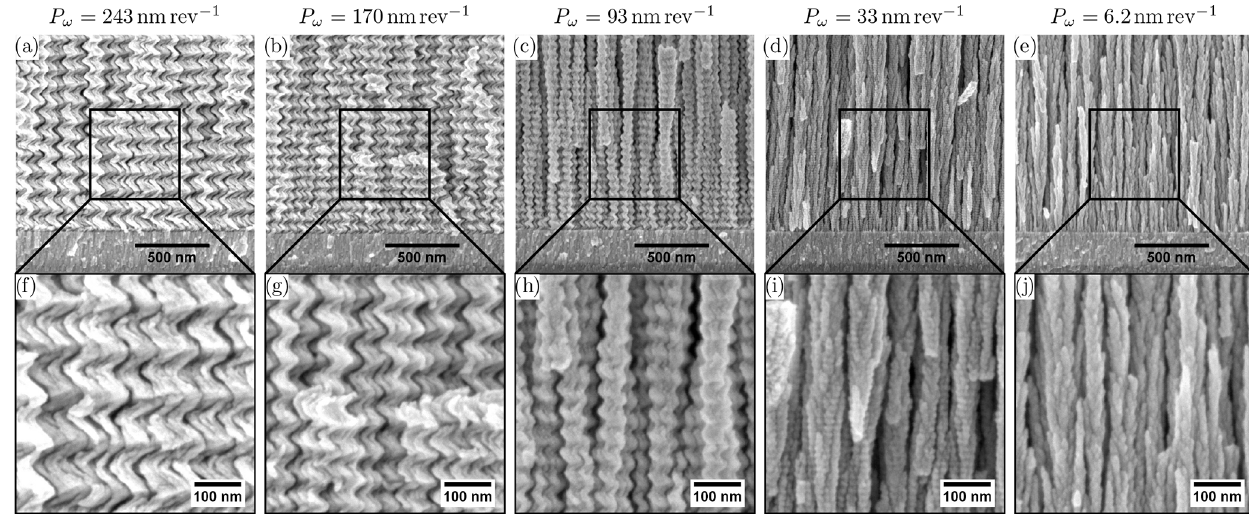
Figure 2. (a) – (e) Layer structure and (f) – (j) their magnified view of a series of tantalum structures deposited at a deposition angle α of 80 ◦ with decreasing growth pitch P ω . The growth pitch can be used directly to adjust the microstructure.